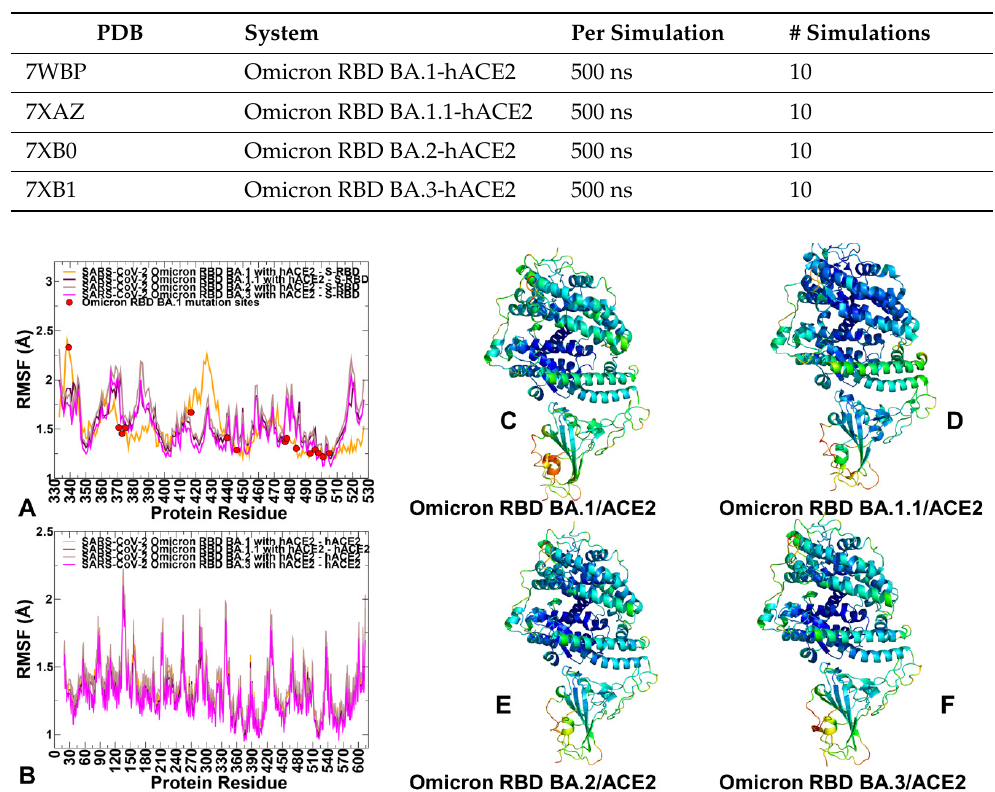
Figure 2. Conformational dynamics profiles obtained by averaging results from 10 independent MD simulations of the Omicron RBD BA.1, BA.1.1, BA.2 and BA.3 complexes with hACE2. ( A ) The RMSF profiles for the RBD residues obtained from MD simulations of the RBD BA.1-hACE2 complex, pdb id 7WBP (in green lines), RBD BA.1.1-hACE2 complex, pdb id 7XAZ (in maroon lines), RBD BA.2-hACE2 complex, pdb id 7XB0 (in light brown lines), and RBD BA.3-hACE2 complex, pdb id 7XB1 (in magenta lines), The positions of Omicron mutational sites are highlighted in red-colored filled circles. ( B ) The RMSF profiles for the hACE2 residues obtained from MD simulations of the Omicron BA.1, BA.1.1, BA.2 and BA3 complexes. The ACE2 dynamics profiles are shown, respectively in green, maroon, light brown and magenta lines for BA.1, BA.1.1, BA.2 and BA3 complexes, respec- tively. Structural maps of the conformational profiles are obtained from MD simulations of Omicron RBD variant complexes. Conformational mobility maps for the Omicron RBD BA.1-hACE2 complex ( C ), the Omicron RBD BA.1.1-hACE2 complex ( D ), the Omicron RBD BA.2-hACE2 complex ( E ), and the Omicron RBD BA.3-hACE2 complex ( F ). The structures are shown in ribbons with the rigidity- flexibility sliding scale colored from blue (most rigid) to red (most flexible). The positions of sites targeted by Omicron mutations are shown in spheres colored according to their mobility level.